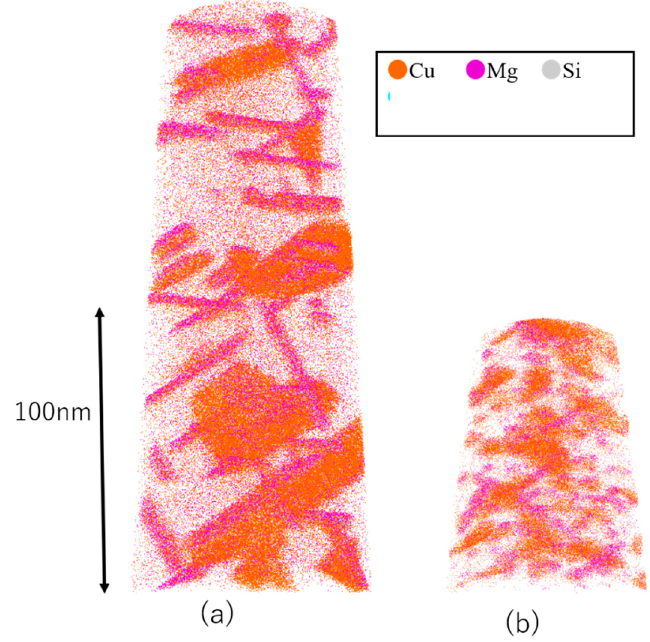
Figure 13. Atom probe elemental mapping for ( a ) specimen unirradiated but only aged at 423 K for 30 days, and ( b ) specimen pre-irradiated with iodine ions to the fluence of 5 × 10 15 / cm 2 and subsequently aged at 423 K for 30 days.